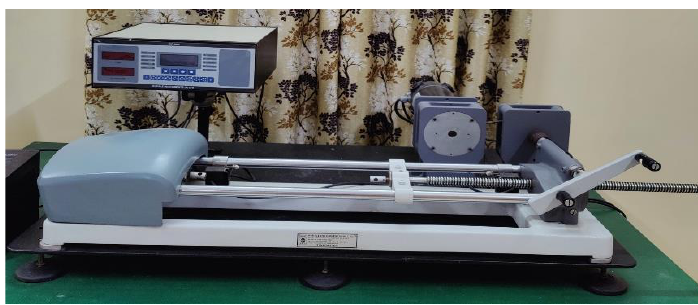
Figure 3. Electronic tensiometer for flexural and tensile properties testing.